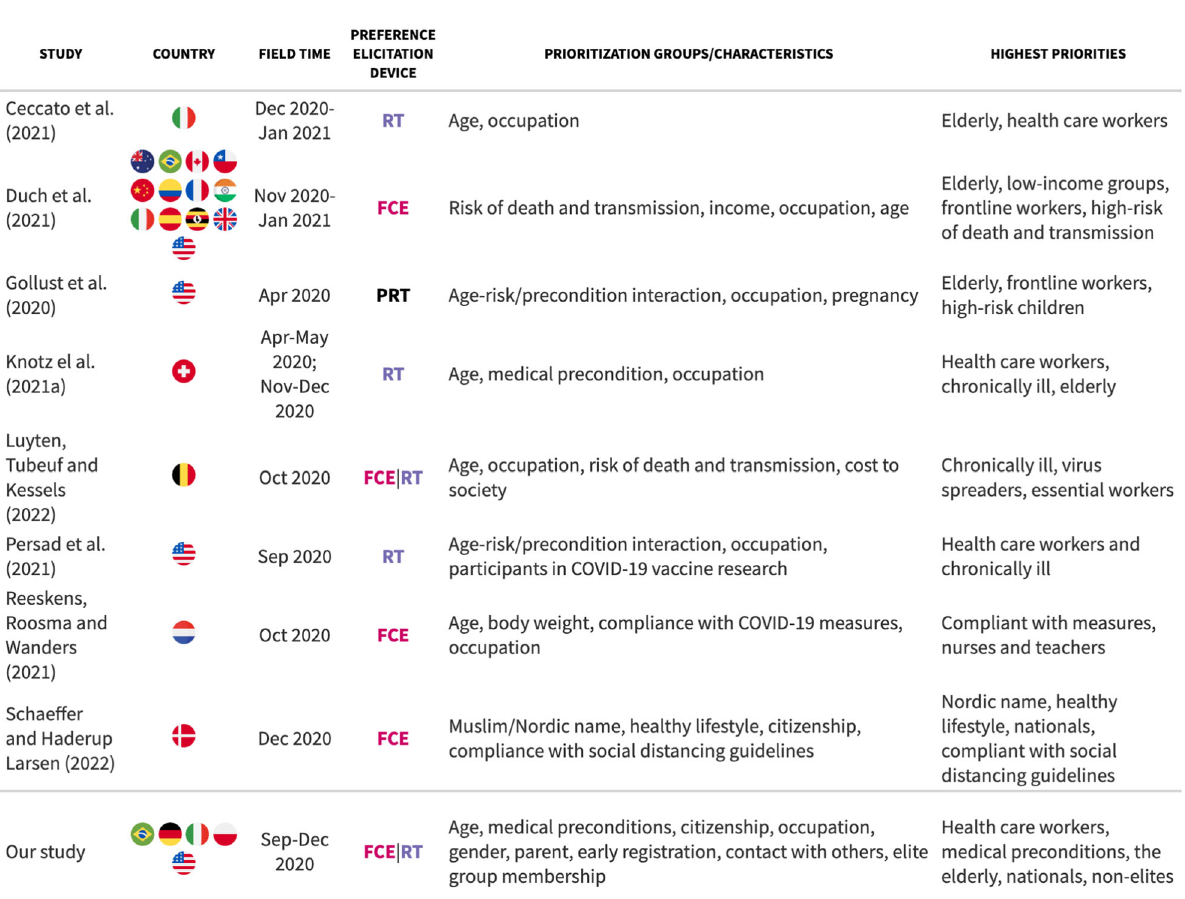
Table 2 Overview of studies on COVID-19 vaccination allocation preferences.